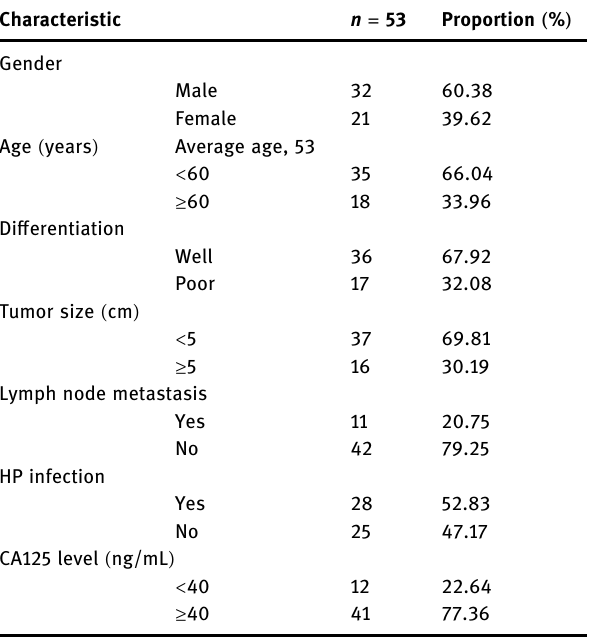
Table 1: Clinicopathological features of GC patients